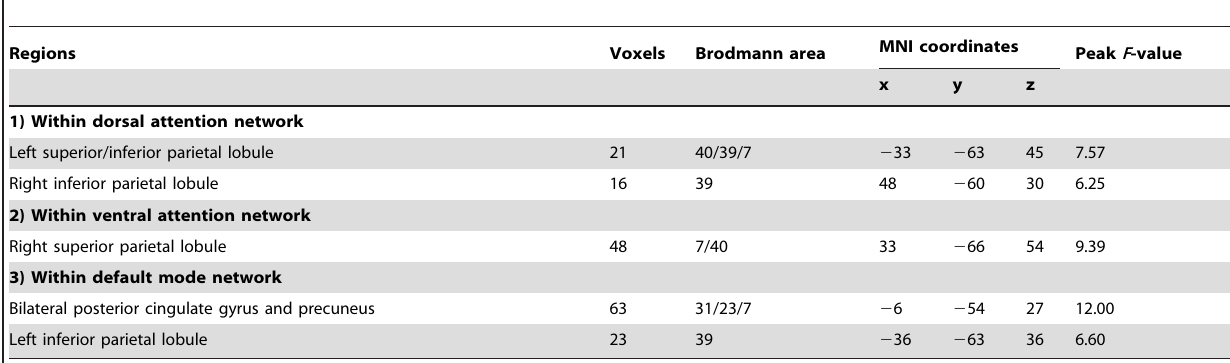
Table 2. Regions showing significantly different functional connectivity within attention-related brain networks across the three